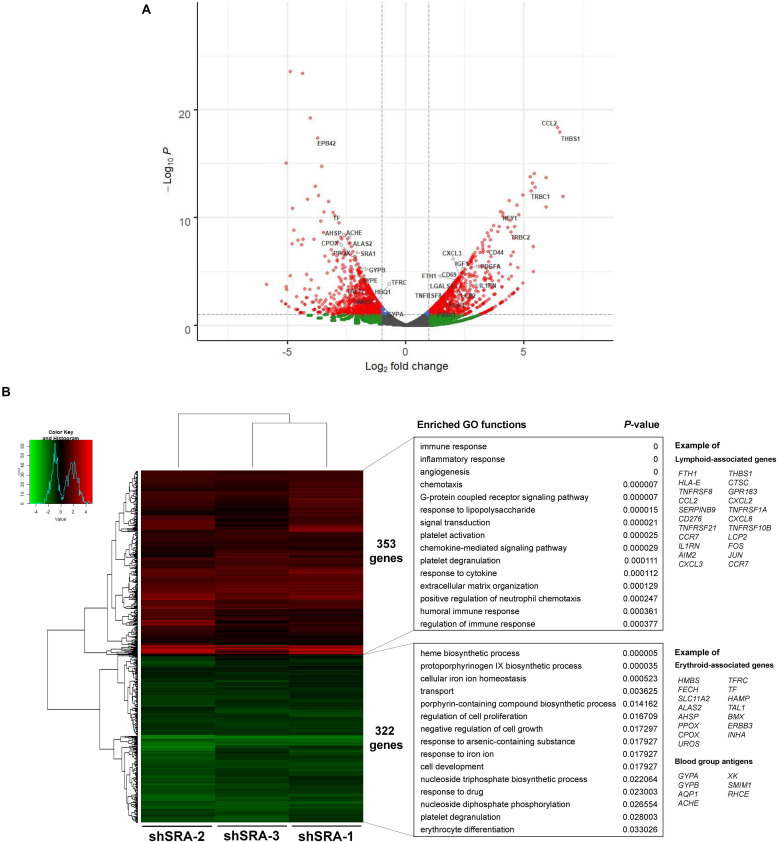
SRA regulates transcription of hematopoiesis-related genes in the human erythroblast cells K562. The lncRNA SRA controls expression of 675 genes in the human erythroblast cells K562. RNA-seq was performed for cells depleted for SRA using individual shRNA constructs, i.e., shSRA-1, shSRA-2, or shSRA-3, and the control knockdown shLuc. Following silencing of SRA in K562 cells, 322, and 353 genes are down- and up-regulated in SRA knockdown cells, respectively. (A) Volcano plot illustrating changes in gene expression upon SRA silencing. The plot represents statistical significance vs expression fold change between the two conditions. Results from three biological replicates using different shRNA targets are shown. Genes with log2 fold change > 1 or <−1 and p-value < 0.01 are considered to be differentially expressed genes (DEGs) and are shown in red dots. (B) Heat map of DEGs between SRA knockdown samples and the control was analyzed. Pseudocount of TPMs was employed for calculation of fold-change using TPM + 1. The fold-change was calculated from TPM values of knockdown per TPM values of control, and the graph was plotted by representing log2(fold-change) of DEGs. Categories of enriched gene ontologies (GO) of genes up- and down-regulated by SRA in K562 (p-value < 0.05) were analyzed using DAVID. Examples of genes within the GO terms are shown on the right.